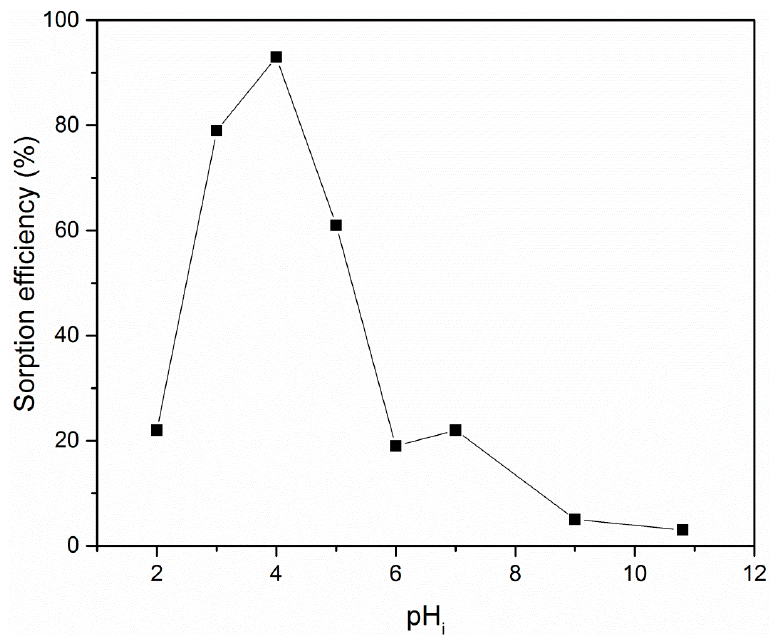
Figure 1. The effect of initial pH value (pH i ) onto sorption efficiency (%); experimental conditions: c 0 = 1 mg L − 1 , temperature 22 °C, stirring rate 170 rpm, contact time 300 min.